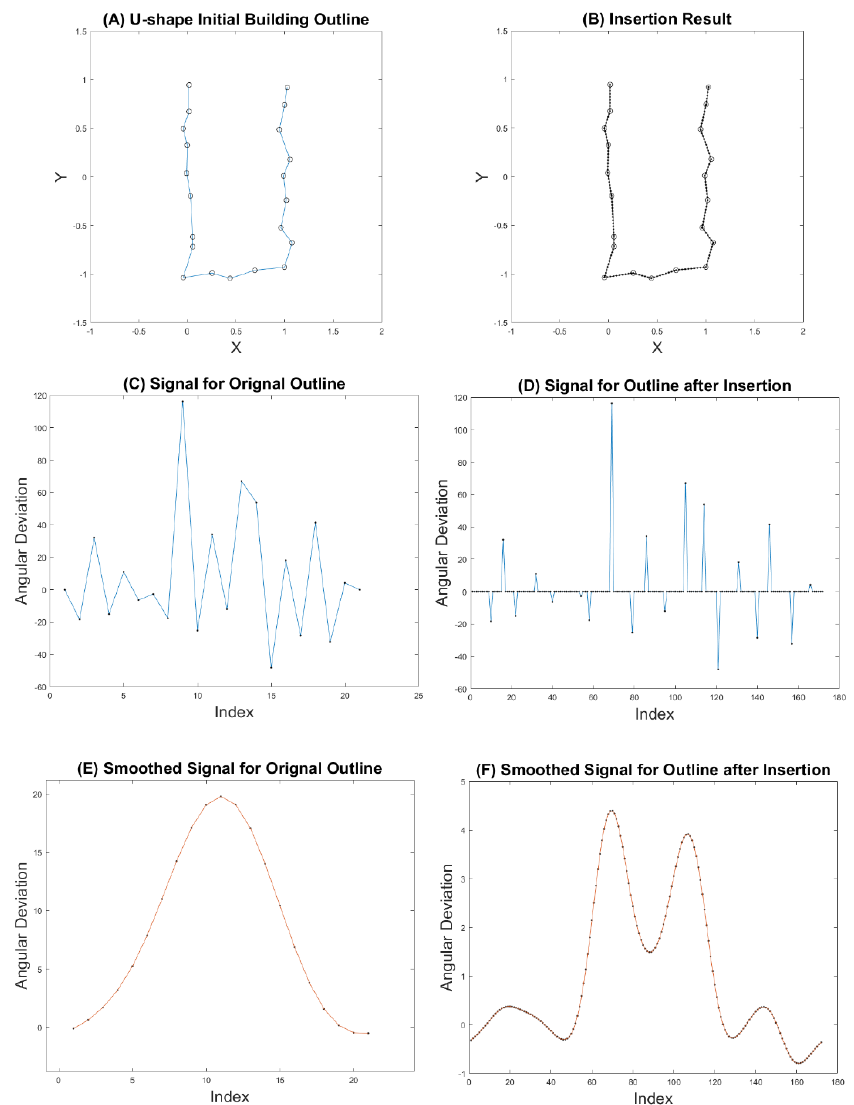
Figure 8. Example of insertion operation. ( A ) The U-shape building outline; ( B ) The outline after applying insertion operation; ( C ) The angular deviation signal of the original U-shape building outline; ( D ) The angular deviation signal of the outline after insertion; ( E ) The smoothed signal of original U-shape outline; ( F ) The smoothed signal of outline after insertion.